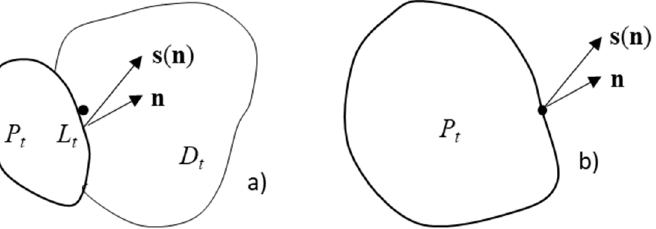
Figure A2. ( a ) Contact forces; ( b ) forces at points in the interior caused by the surrounding environ- ment [63].